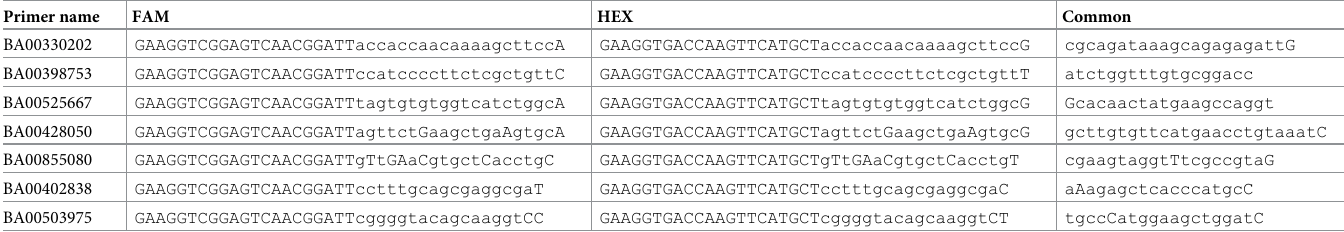
Table 1. KASP markers applied on the RIL population of cross PBW 621 × HD 2967. Primer